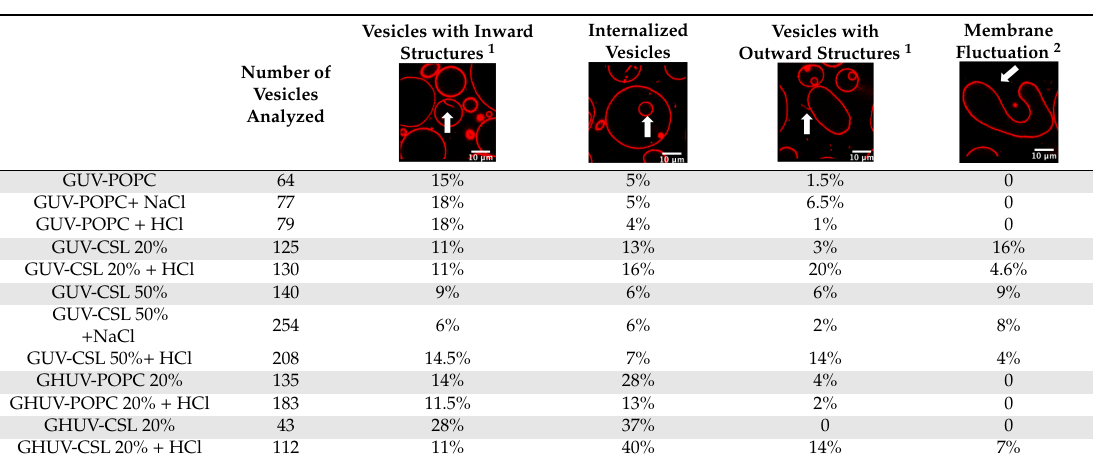
GUV-CSL 50% + HCl 208 14.5% 7% 14% 4% GHUV-POPC 20% 135 14% 0 GHUV-POPC 20% +